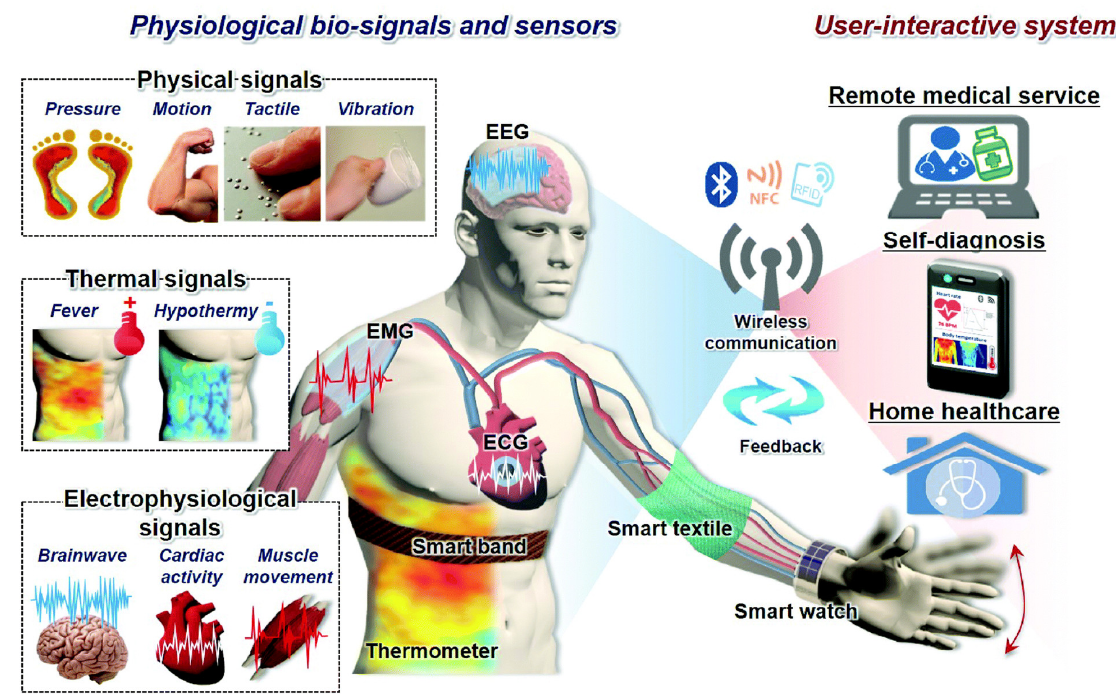
Figure 5. Human body biosignals and the healthcare sensors that measure them. Reproduced with